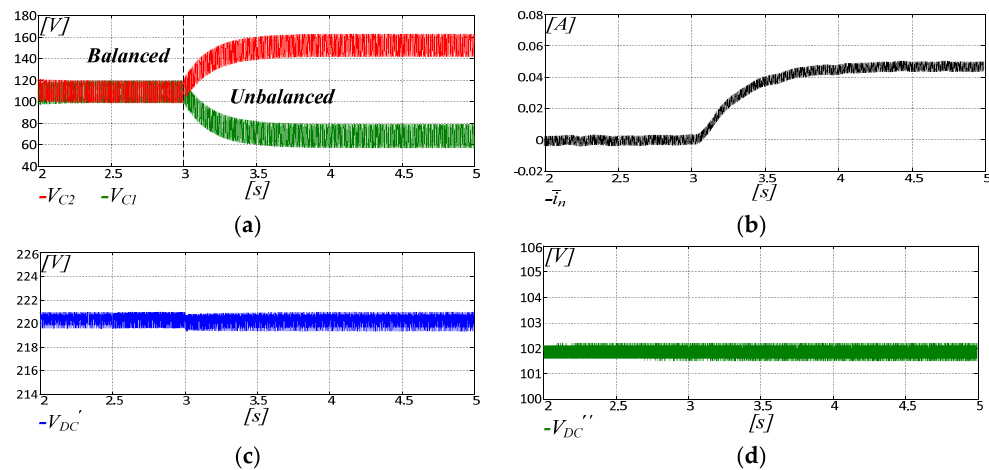
Figure 13. SimPower System model. ( a ) DC bus capacitor voltages V C1 and V C2. ( b ) i n = i C1 − i C2 . ( c ) output voltage V DC '. ( d ) TLI DC bus voltage V DC ''.